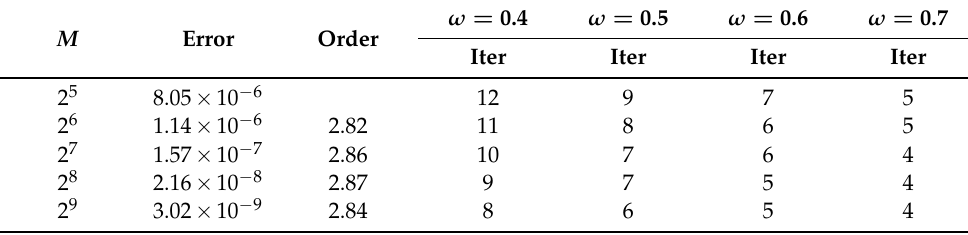
Table 3. L 2 errors for (72) with different ω by the third-order